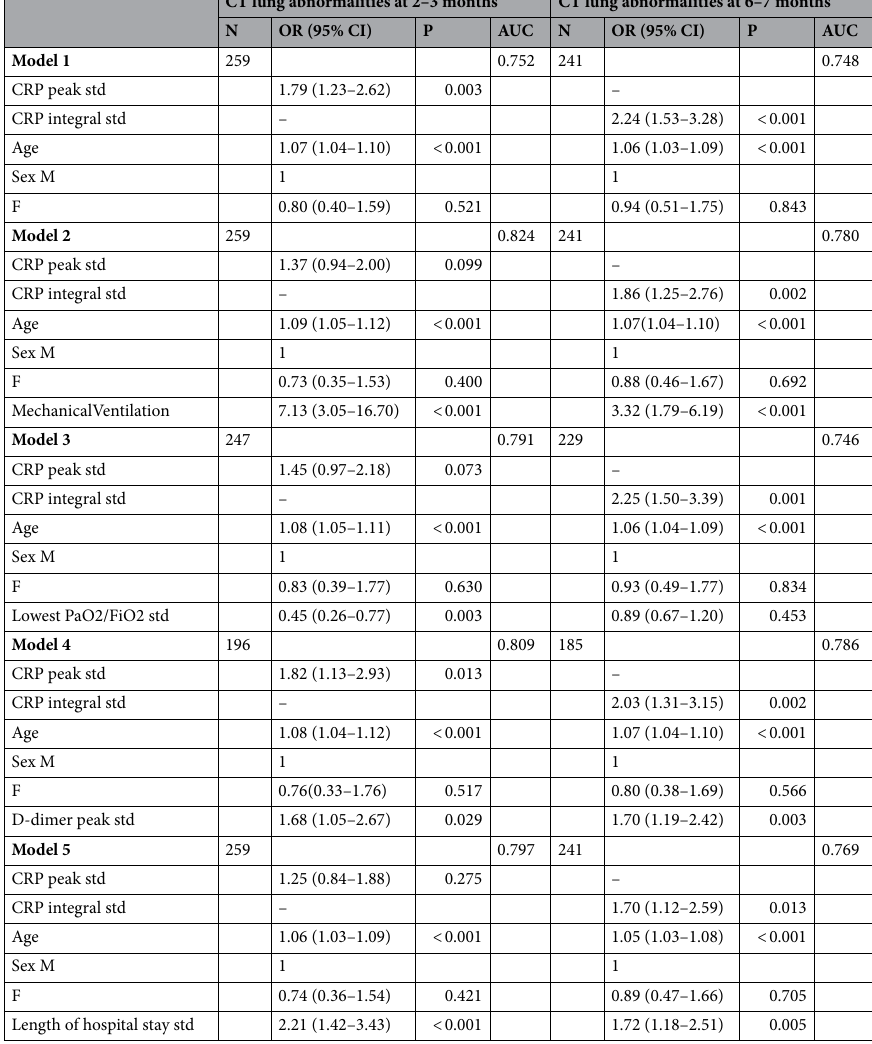
Table 2. Models for CT abnormalities at 2–3 and at 6–7 months including age, sex, and standardized CRP curve descriptors alone (Model 1) and adding other standardized measures of disease severity not directly (or not only) linked to hyperinflammation: mechanical ventilation (Model 2), lowest PaO2/FiO2 (Model 3), D-dimer peak (Model 4), length of hospital stay (Model 5). Std, standardized; OR, odds ratio; CI, confidence interval; AUC, area under the ROC curve; CRP, C-reactive protein. For standardized variables we report OR for one standard deviation increase of the variable; for age we report the OR for one year